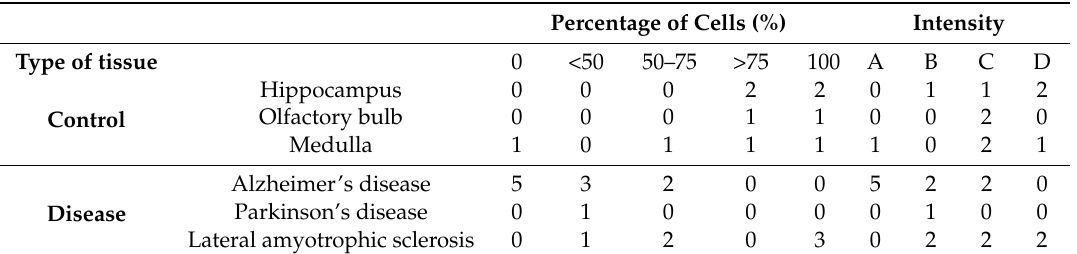
Disease Parkinson’s